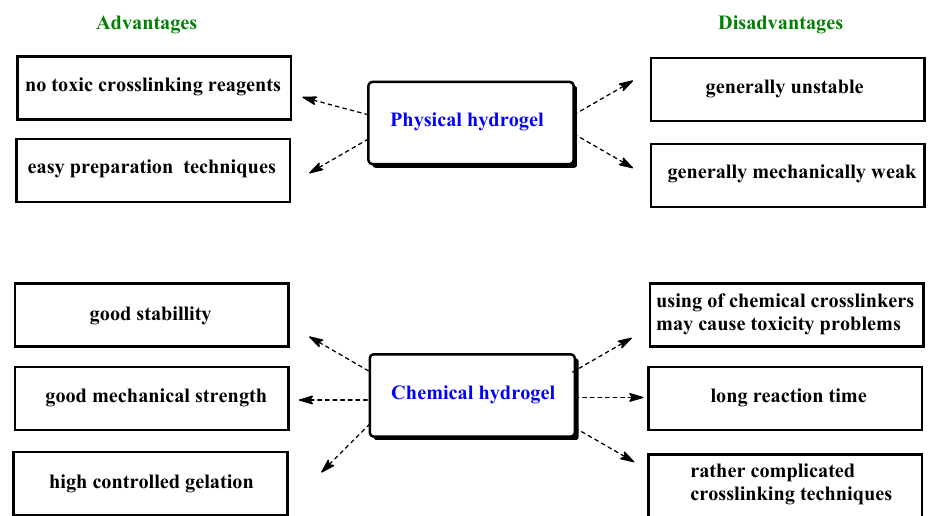
Figure 2. Advantages and disadvantages of chemical and physical hydrogels.